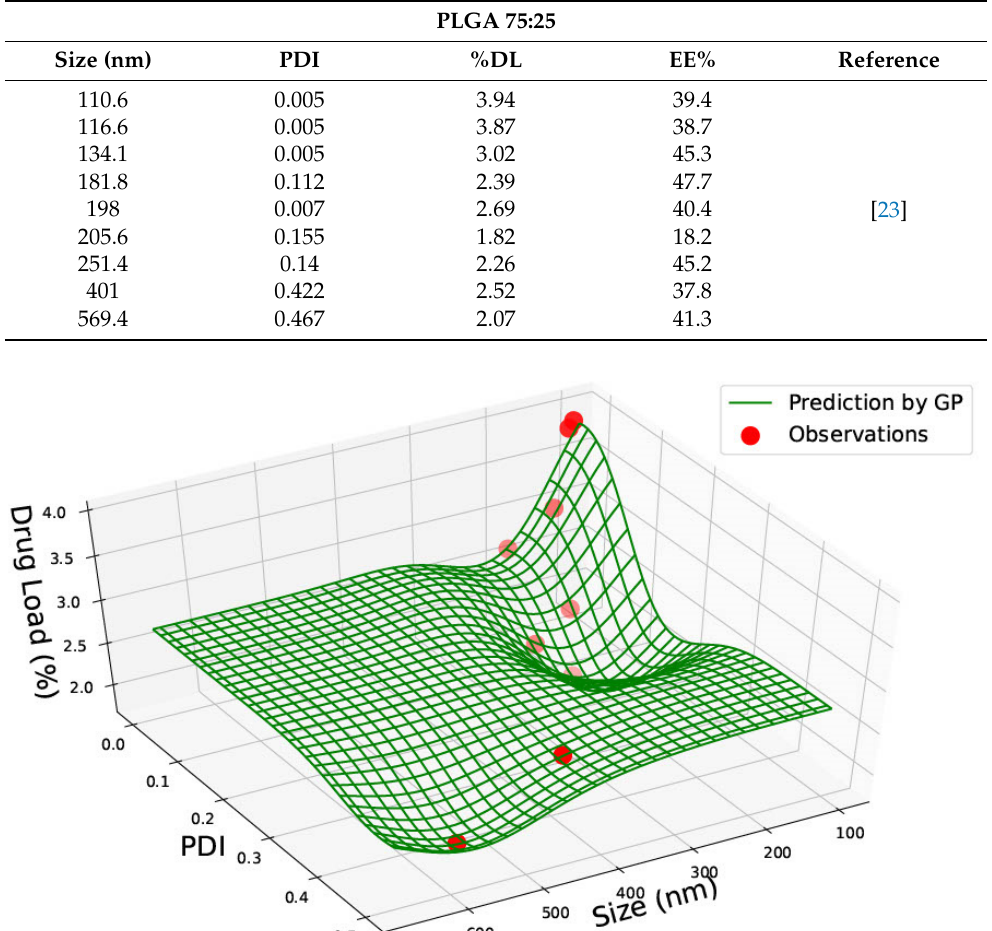
Table 3. Data Extracted PLGA 75:25.